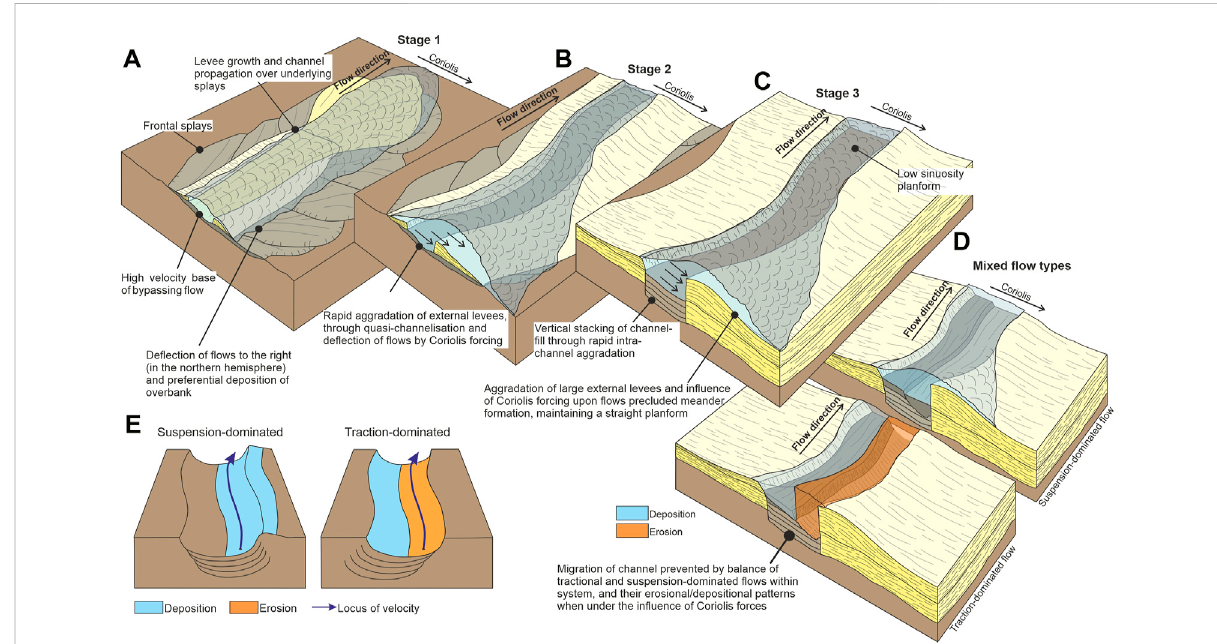
FIGURE 12 Model for evolution of high latitude channel systems. Stage 1 (A) shows early stagesof channel propagation, with system incising frontal splays, and small levees present in up-dip sections; if fl ow velocities are low, then Coriolis forcing may result in preferential splay deposition on the right- hand side. Stage 2 (B) represents a more mature system, with Coriolis forcing able to de fl ect fl ows to the right-hand side, resulting in asymmetrical levee growth. In the later stages of system evolution (C) , the channel is ‘ fi xed ’ in place, with large external levees preventing lateral migration – creating vertical stacking of channel fi ll. Mixed fl ow types may also be responsible for vertical stacking (D) , with work by Cossu et al. (2015) predicting different migration directions for traction and suspension-dominated fl ows (E) , modi fi ed from Cossu et al., 2015), the interplay of which could result in an overall vertical